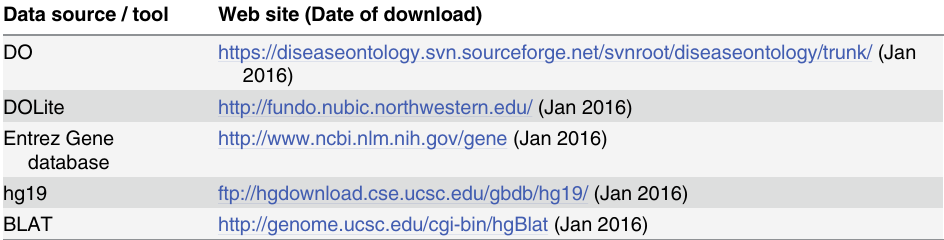
Table 1. Data sources and tools used for identifying significant relationships between sequences and diseases. Data source /